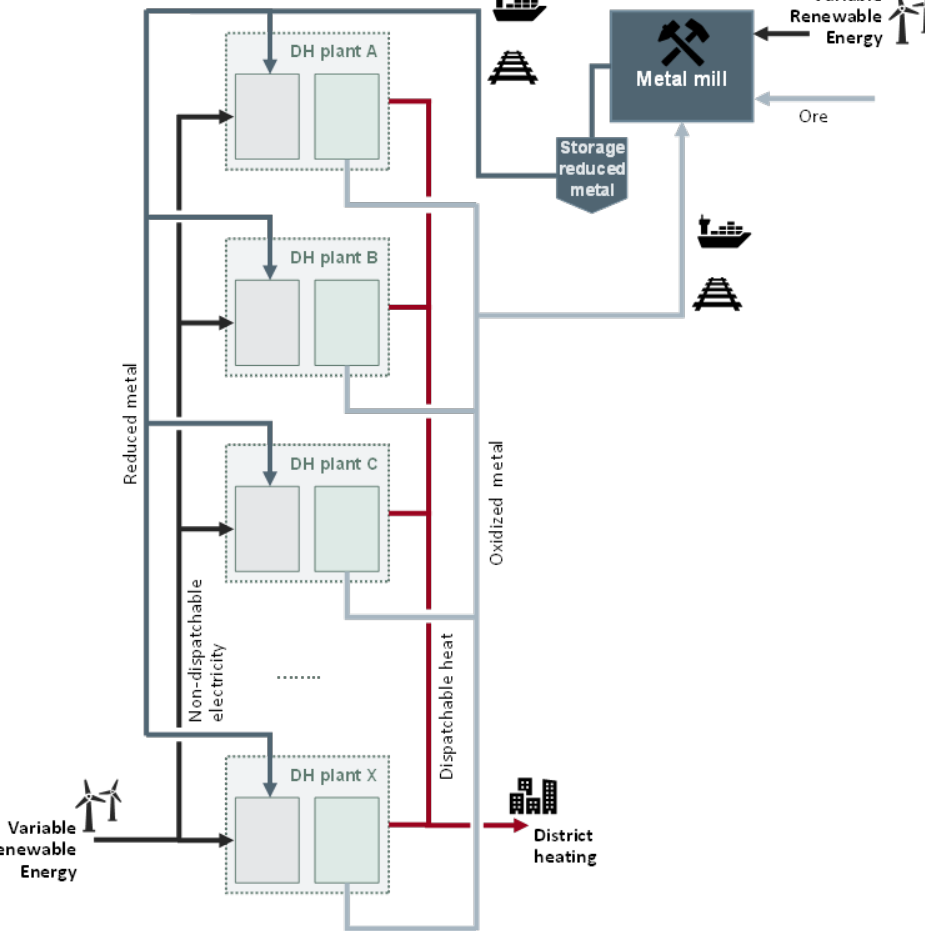
Figure 4. Scheme at the national level for the storage of energy and production of DH from renew- able electricity using an iron redox cycle. The iron mills, located in the northern region of Sweden, maintain a backup storage system for reduced iron, which can be used for make-up or to cover unexpected peaks in the heat demand. Depleted iron oxide is sent back to the iron mills. The trans- portation of iron relies on the transport infrastructure and logistics already provided by the iron